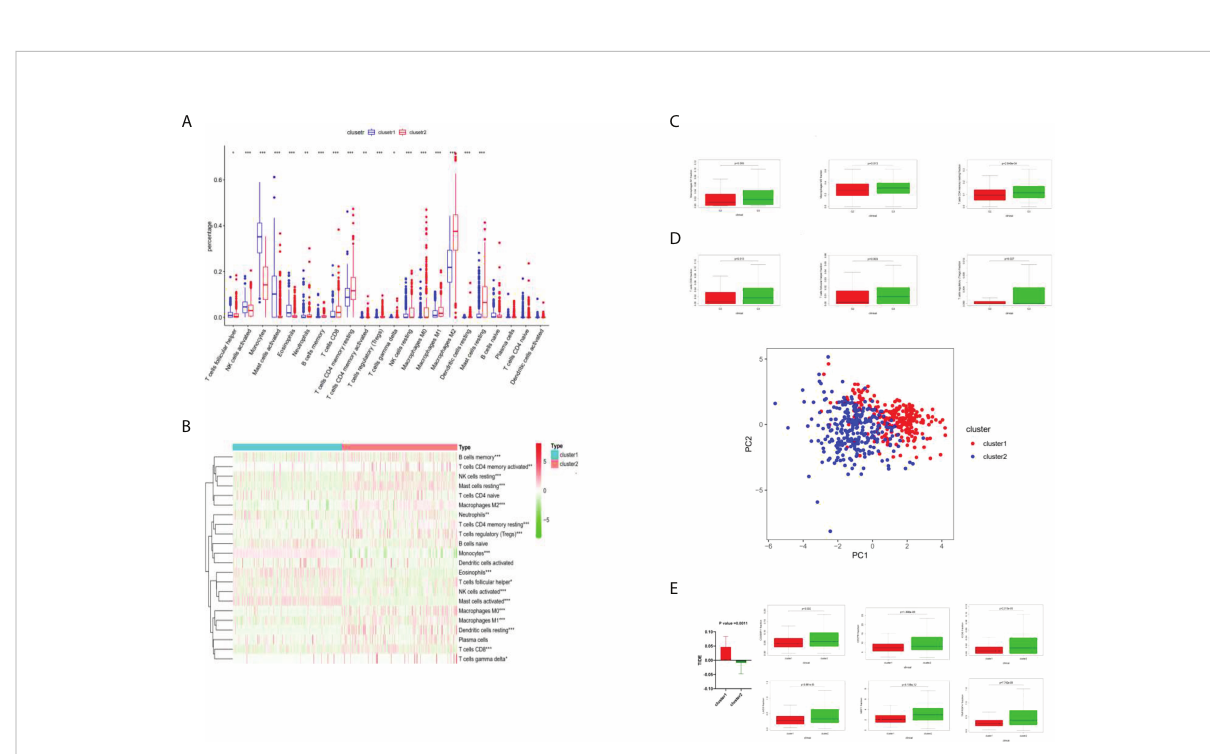
FIGURE 3 Immune cell analysis by cluster 1 and cluster 2. (A) Boxplots of immune cell difference analysis. *P <0.05; **P <0.01; ***P <0.001. (B) Heat diagram of different degrees of immune cell in fi ltration between cluster 1 and cluster 2. (C) Different levels of immune cell in fi ltration were different in the G2 and G3 phases. (D) The degrees of immune cell in fi ltration of all samples were analyzed by principal component analysis, and the above clustering can be well divided into two categories. (E) TIDE value